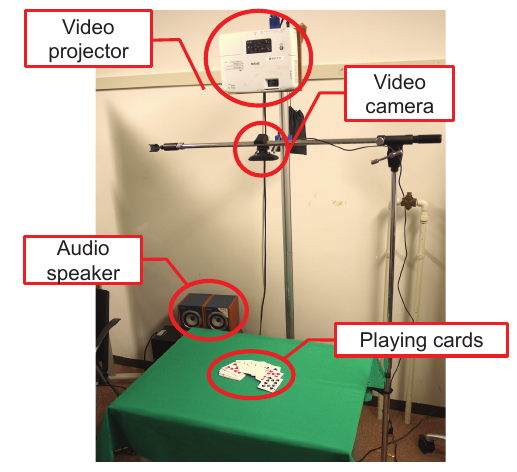
Figure 1. Appearance of the system